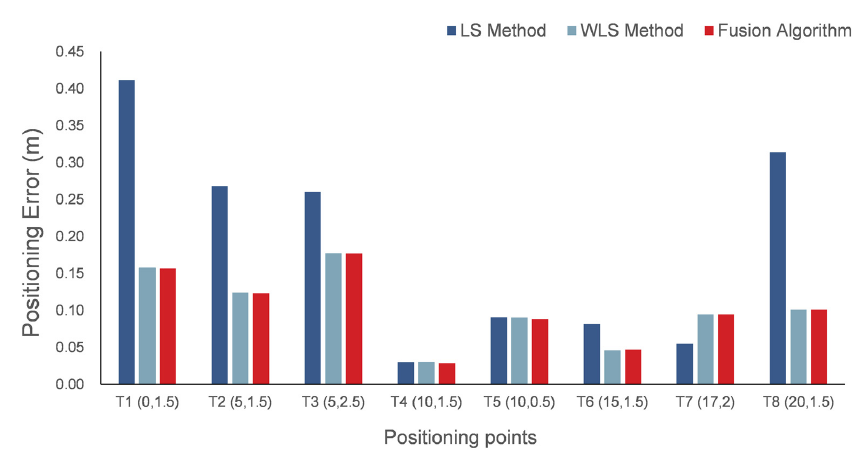
Figure 10. RMS error of different points in Scene B. Table 4. Positioning error of each point in static experiment.